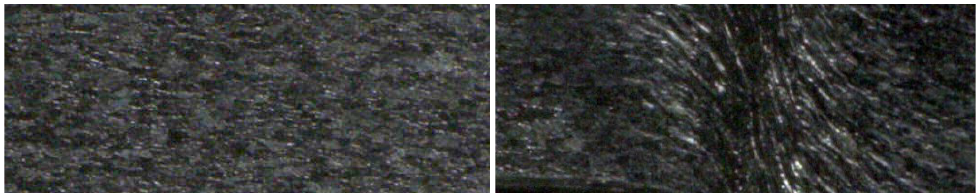
Figure 3. Undeformed image (left) and deformed image during the separation process.